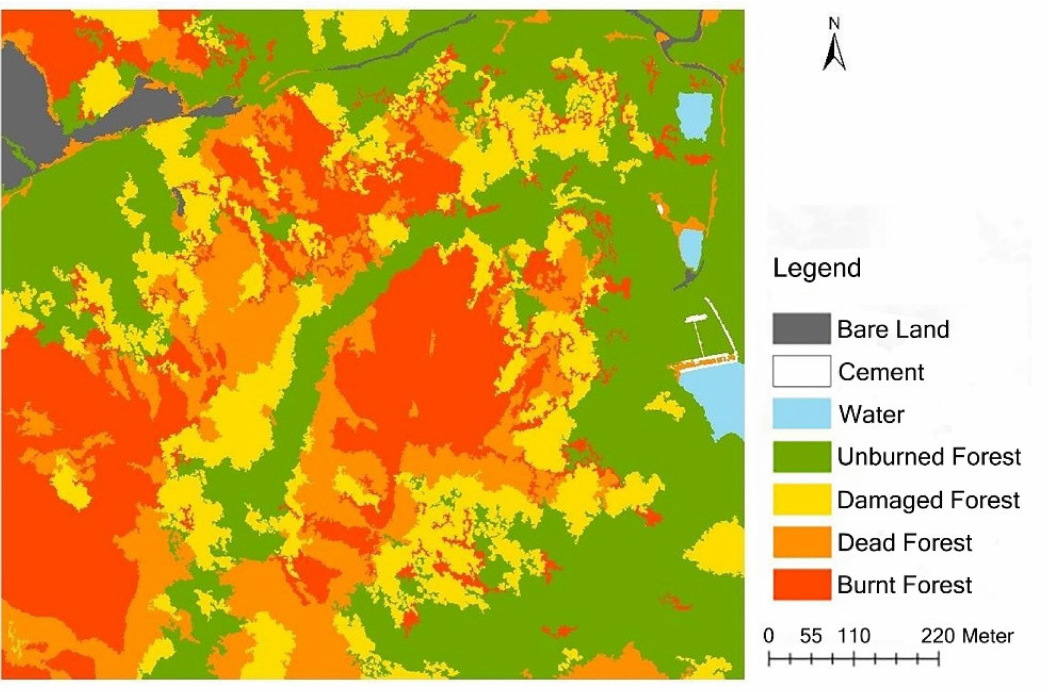
Figure 7. The classification of forest burn severity based on the support vector machine.